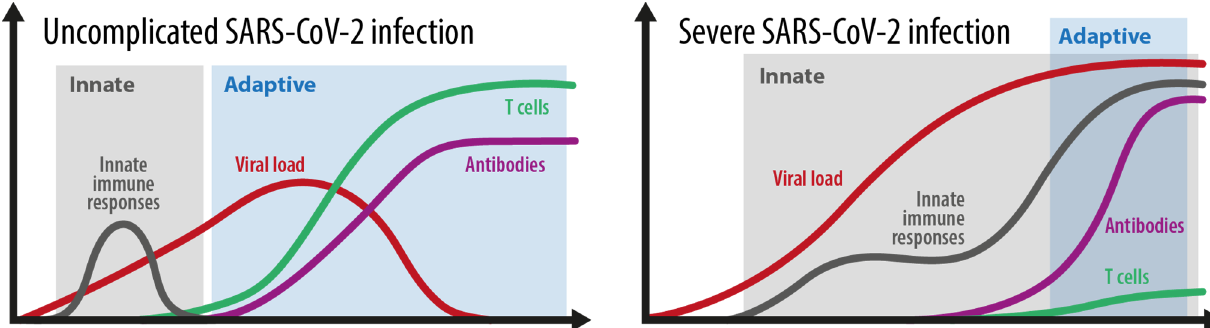
Figure 2. The kinetics of the innate and adaptive immune responses in simple versus severe SARS-CoV-2 infections. Grey area: innate immune response. Blue area: adaptive immune response. Adopted from [52] .